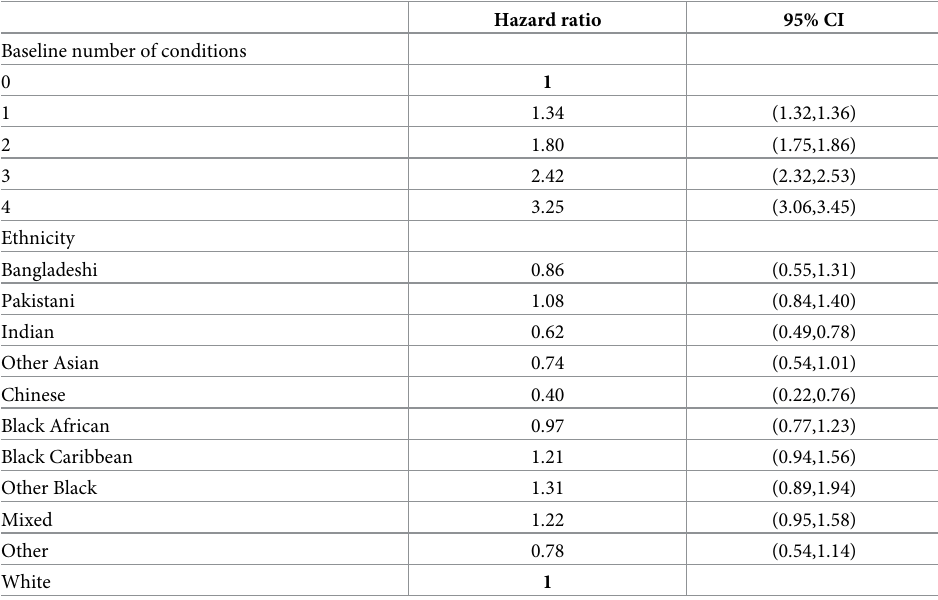
Table 2. Mortality hazard ratios for baseline number of conditions and ethnicity estimated at age 50 (assuming association between number of conditions and mortality is same for all ethnic groups) a . Hazard ratio 95%